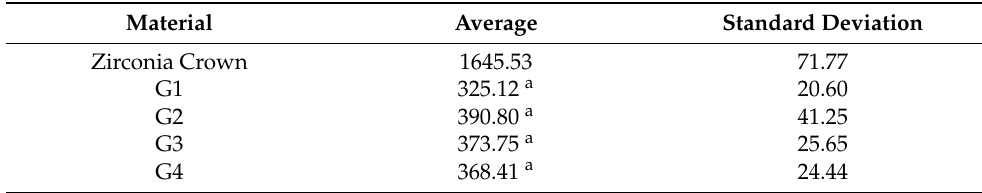
Table 2. Nanohardness 1 of zirconia and implants used in the study. Same lower case letter means no statistically significant differences between the implant